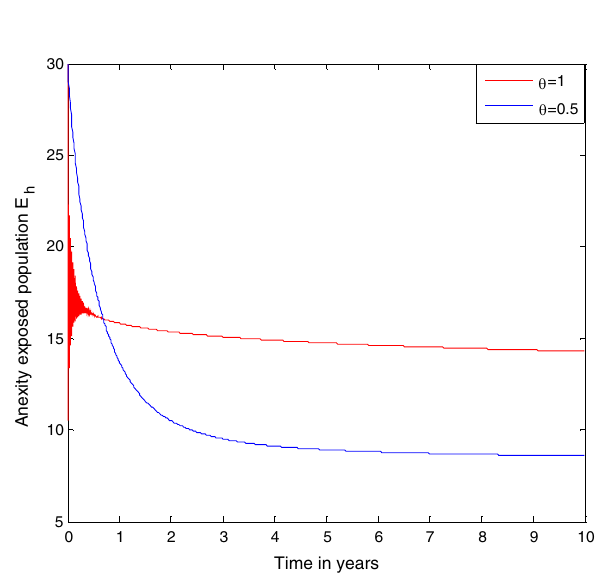
Figure 8. Order of derivative( memory) effects on anxiety exposed population E h